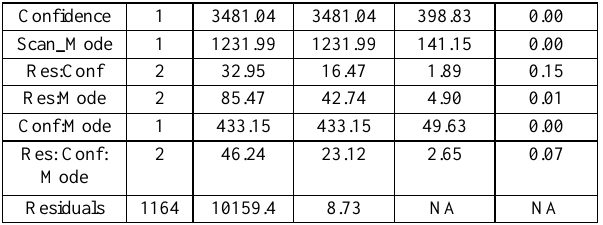
Table 4. Results of three-way ANOVA A boxplot of DBH errors grouped by resolution, confidence, and scanning mode is shown in Figure 5. Method 4 (Scanning